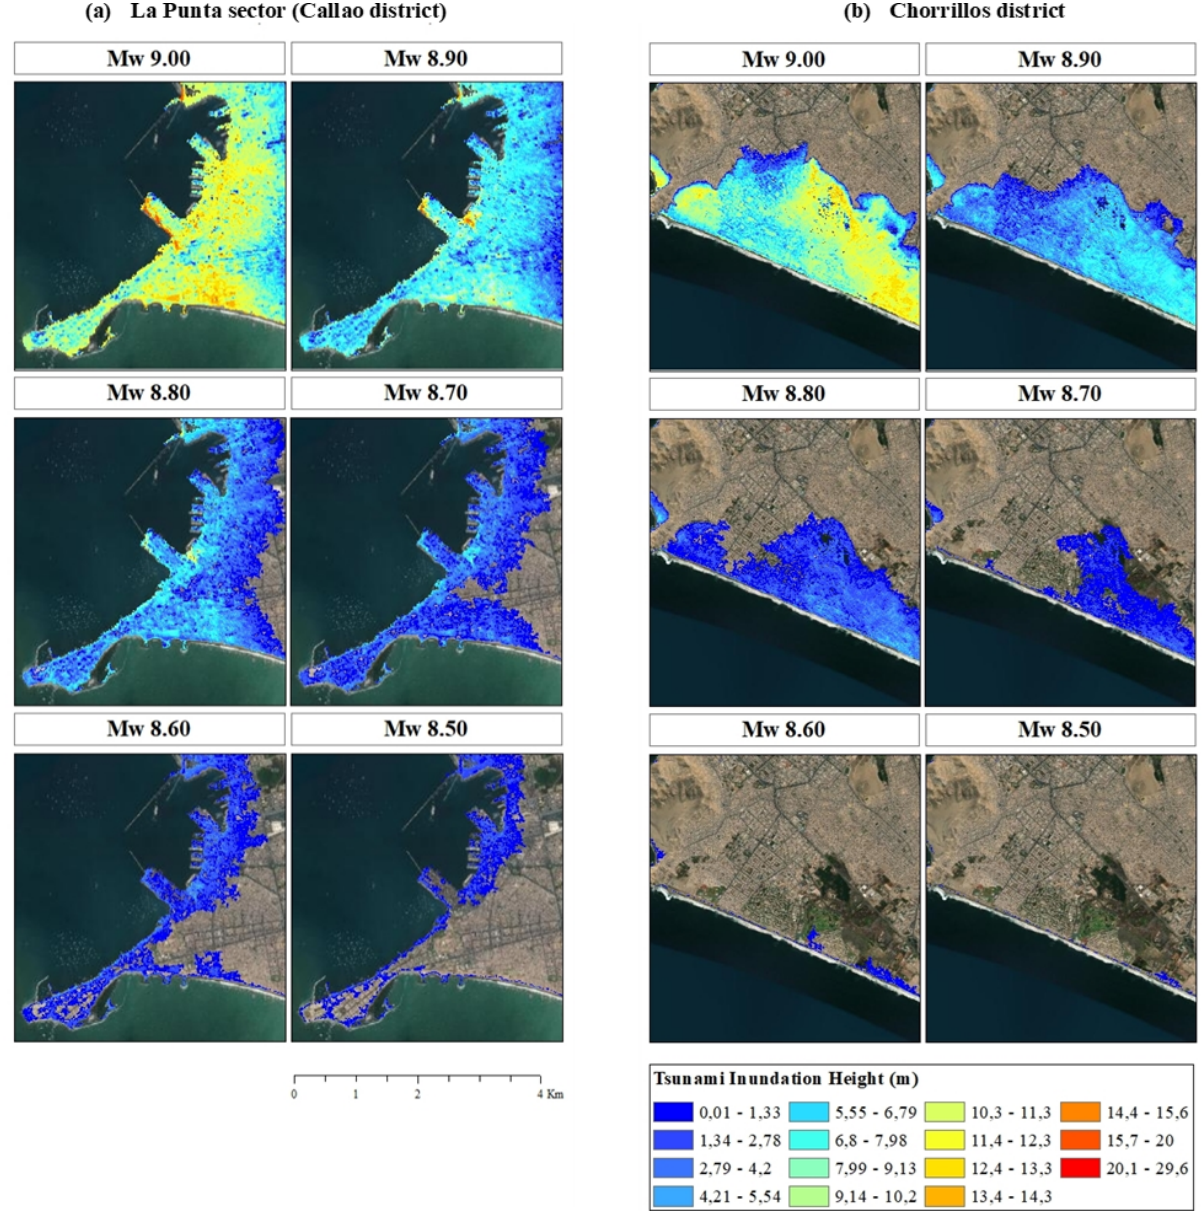
Figure 4. Expected tsunami inundation height (m) for two local areas within Lima for six tsunami scenarios (with locations in Fig. 1). Map data: © Google Earth